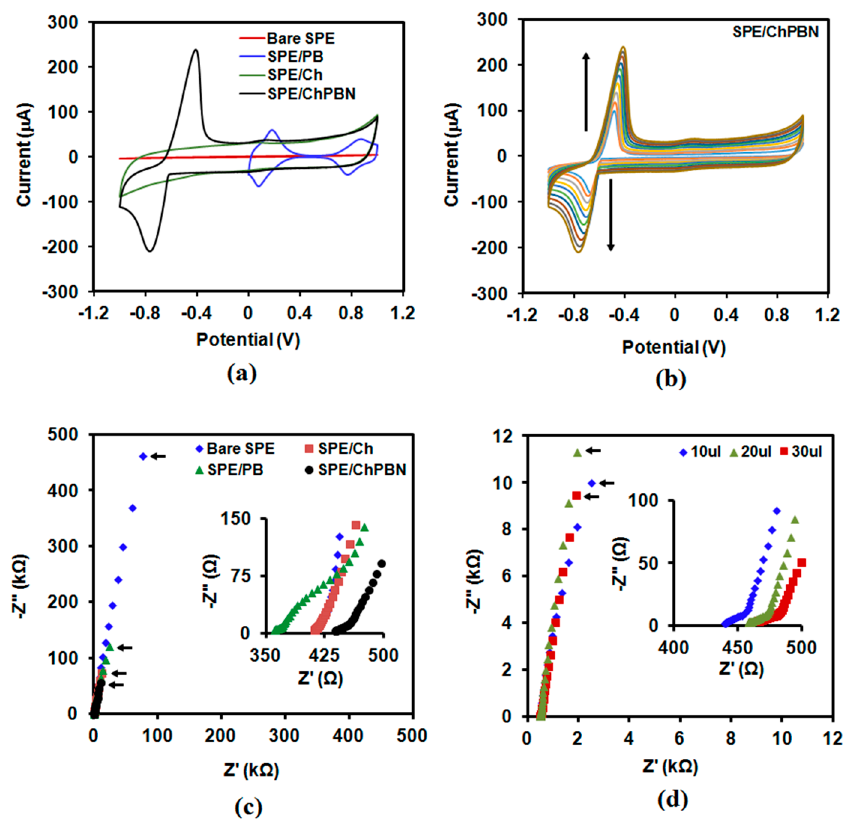
Figure 4. Electrochemical analysis with ChPBN thin films: ( a ) CV curves of SPE/ChPBN compared to three control samples (bare SPE, SPE/PB and SPE/Ch; see the main text for the definitions); ( b ) the effect of scan rate on the CV curves of SPE/ChPBN. Arrows indicate the increase of scan rate from 10–100 mV/s; ( c ) Nyquist plots from EIS spectra of SPE/ChPBN and the three reference samples; ( d ) the effect of droplet solution volume on the Nyquist plots of SPE/ChPBN electrodes. Insets in ( c ) and ( d ) are the magnified views of the high frequency regions. The arrows are pointing to the impedance values measured from the lowest frequency, 100 mHz, for each sample; these are the values used to extract capacitance in Table 1.